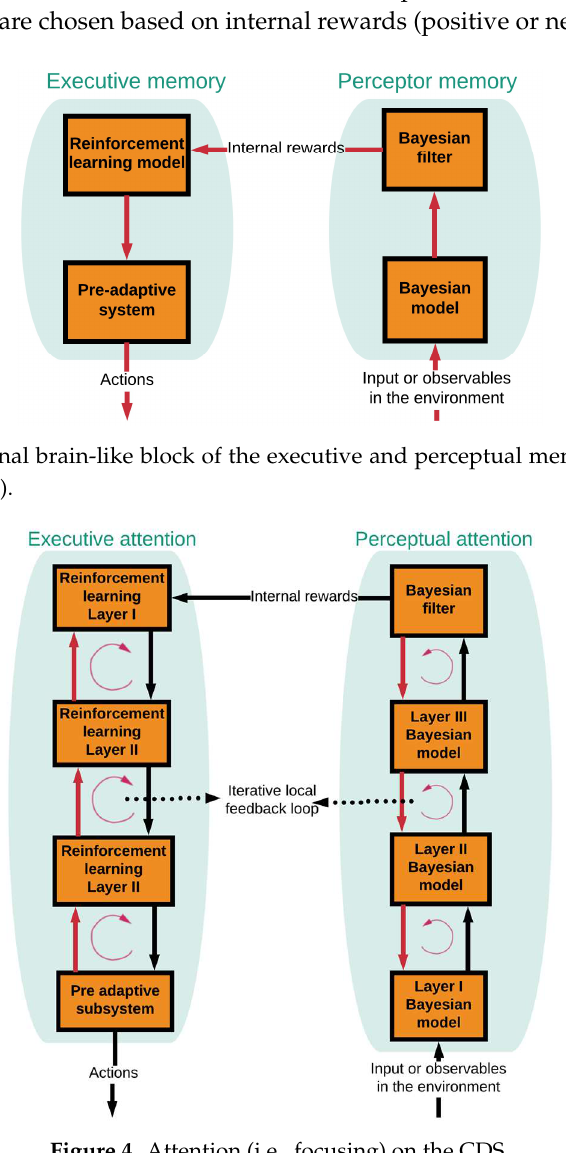
Figure 4. Attention (i.e., focusing) on the CDS.